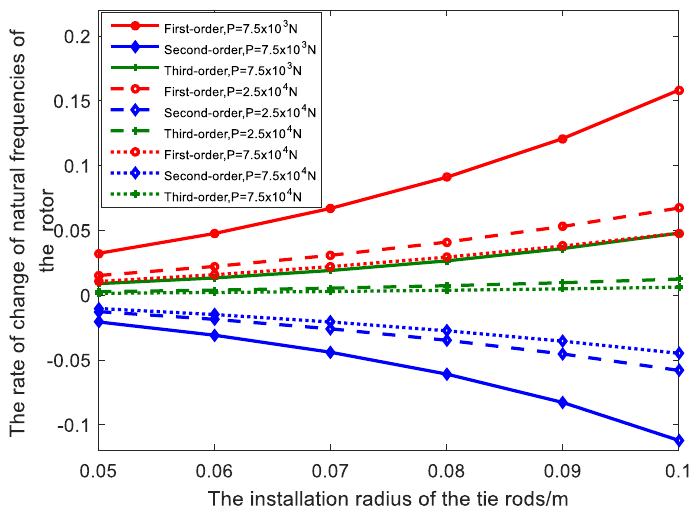
Figure 18. The rate of change of natural frequencies of the RFR with different installation radius of tie rods.